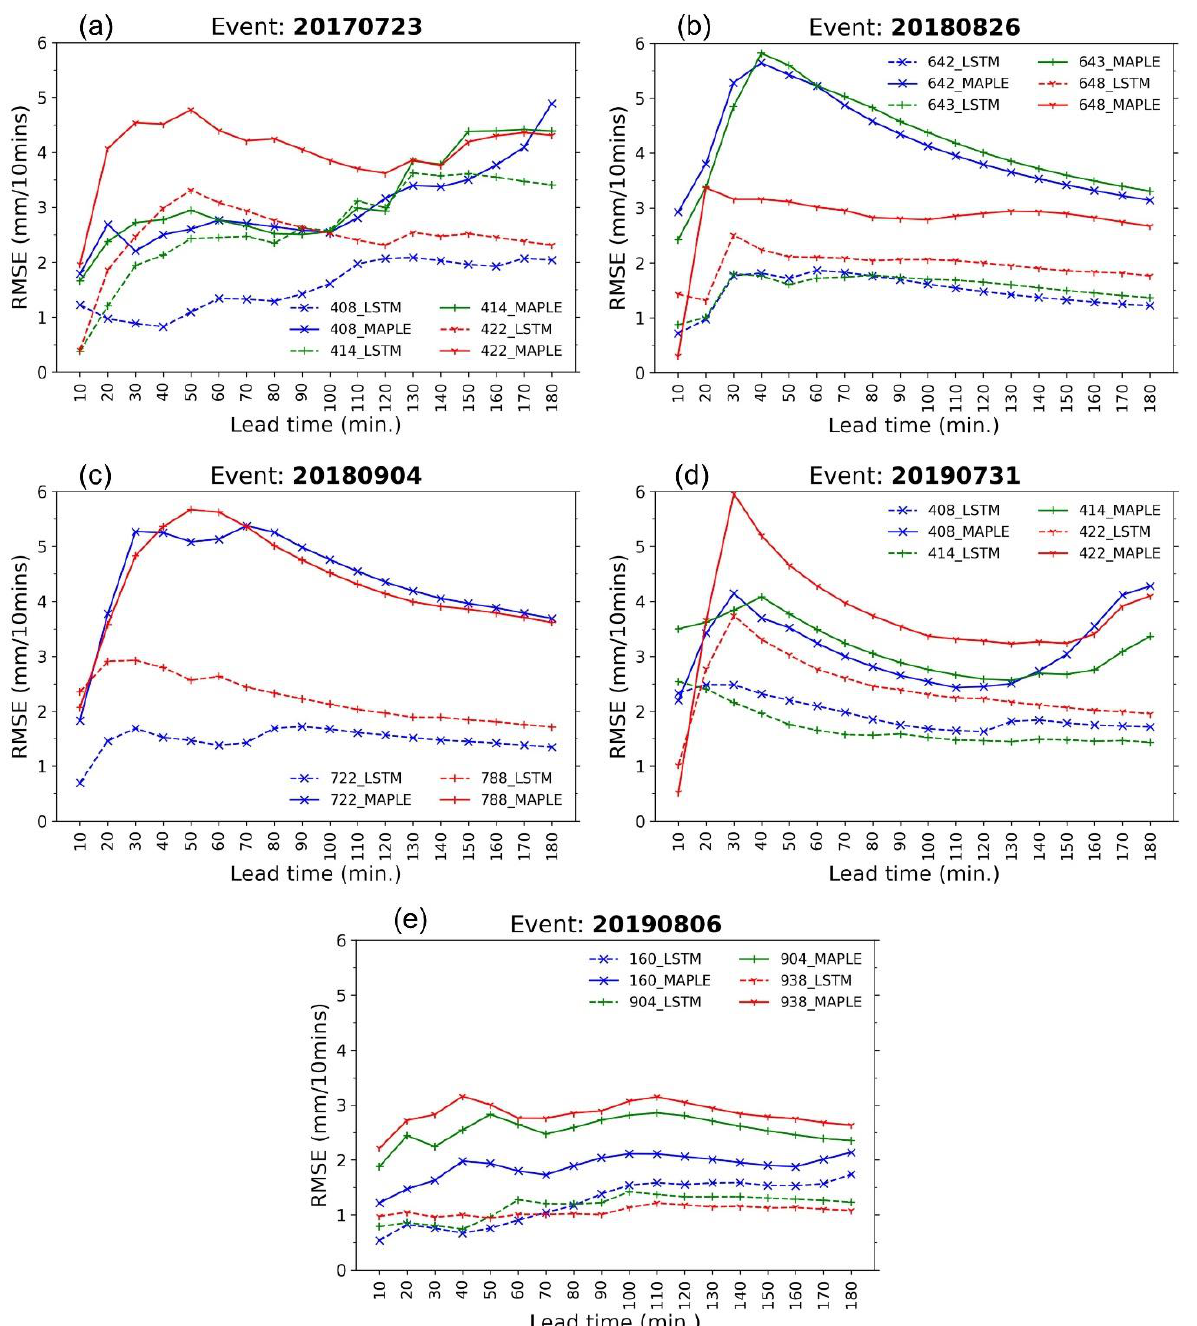
Figure 7. RMSE of the forecasted rainfall from the MAPLE system and LSTM model at the stations in the 5 test events: ( a ) 20170723 event, ( b ) 20180826 event, ( c ) 20180904 event, ( d ) 20190731 event, and ( e ) 20190806 event.